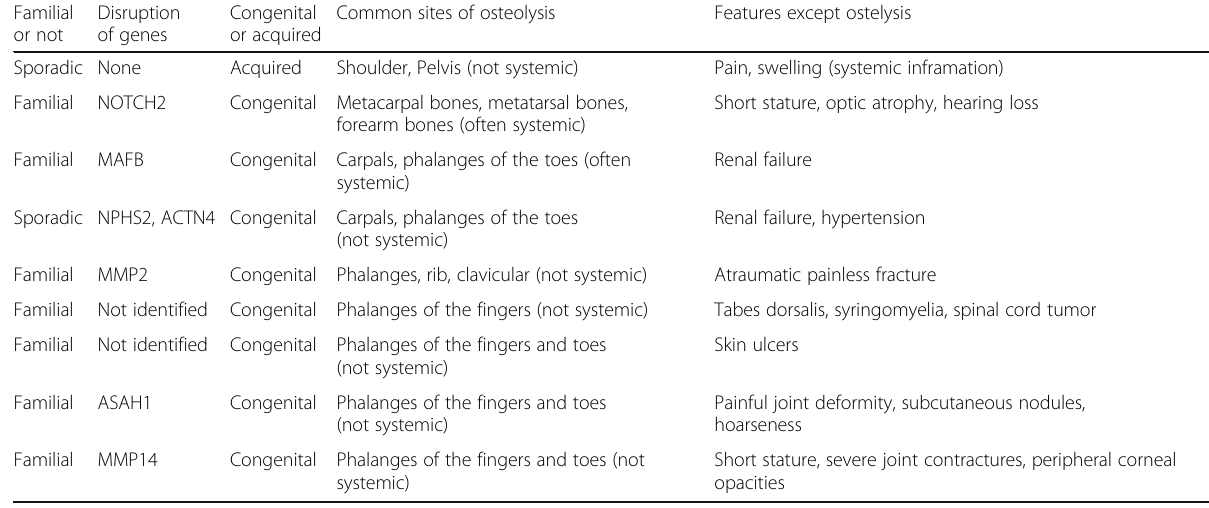
Table 2 Differential diagnoses of osteodysplasia syndromes, which involve bone anomalies in the oral and maxillofacial region Familial or